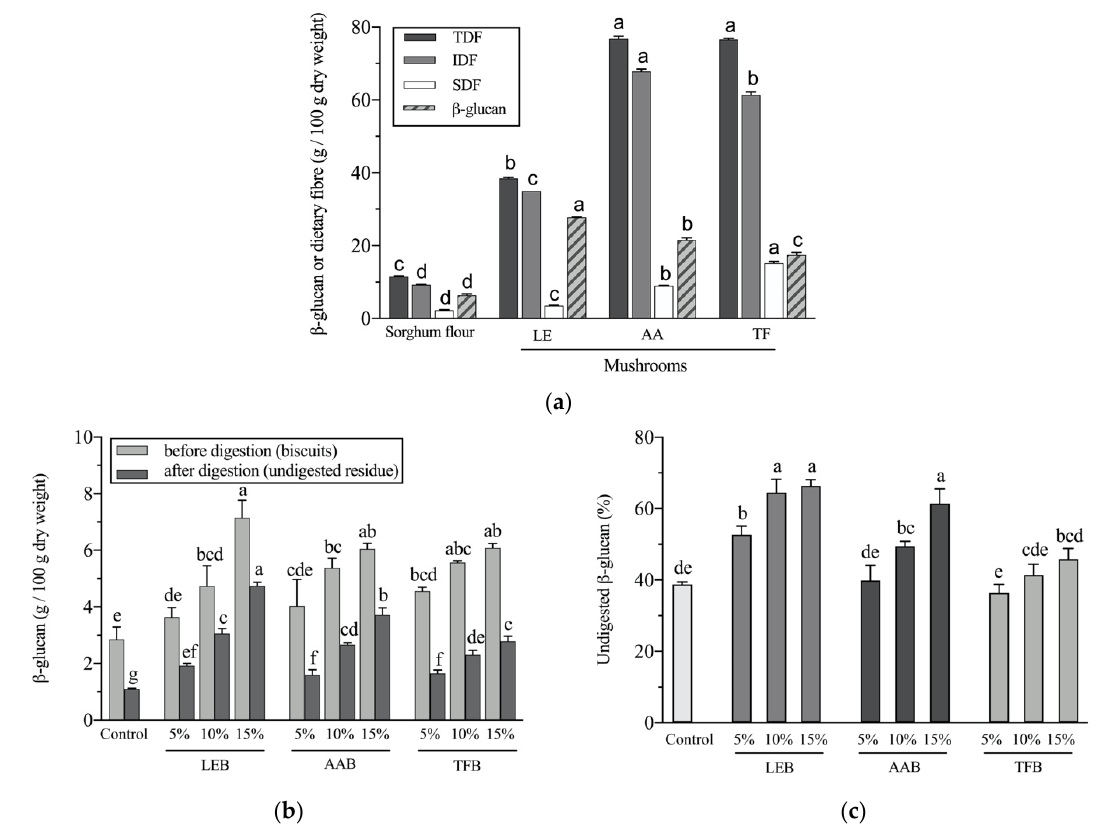
Figure 3. β -glucan and dietary fibre content of sorghum flour and mushrooms ( a ); and β -glucan content of biscuits and undigested residue (g/100 g dry weight biscuit) ( b ); and the undigested β -glucan (%) after gastrointestinal digestion ( c ). Undigested β -glucan (%) was calculated by the following formula: Undigested β -glucan (%) = (gram of β -glucan in the undigested residue/gram of β -glucan in the initial biscuits) × 100. Values = means ± standard deviation ( n = 3). The statistical analysis of significance was performed between four of the materials for figure ( a ) and between 10 of the biscuit samples for figures ( b , c ). Products with different letters are significantly different ( p < 0.05). LEB— L. edodes biscuit; AAB— A. auricula biscuit; TFB— T. fuciformis biscuit.